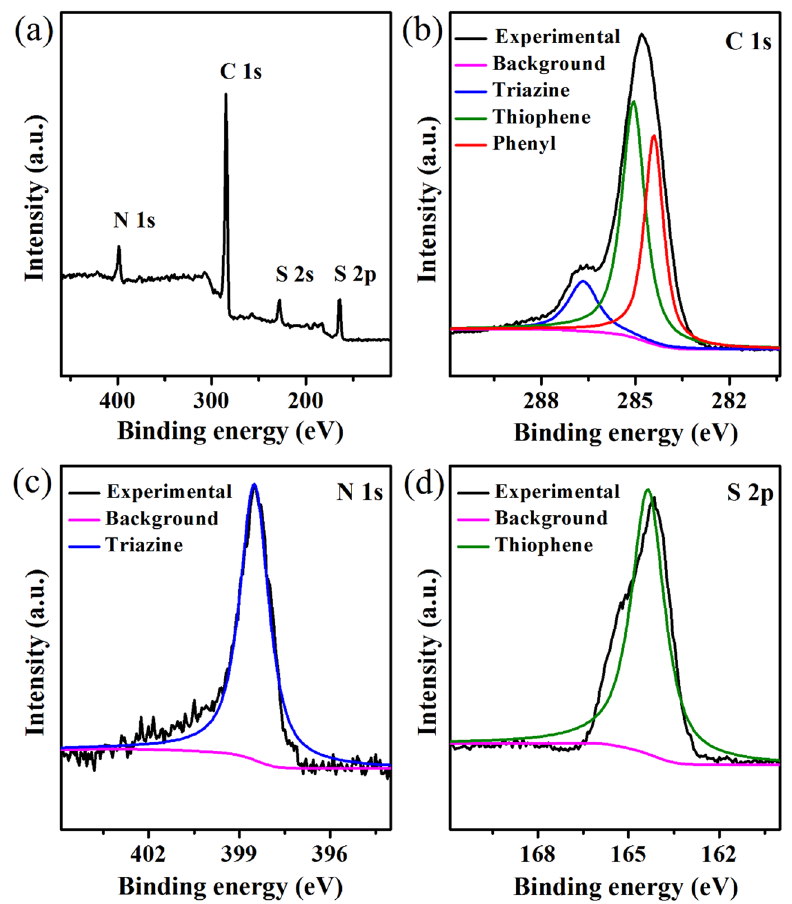
Figure 2: ( a ) XPS survey, ( b ) C 1s, ( c ) N 1s, and ( d ) S 2p spectra of TBrTh – BTBPE –